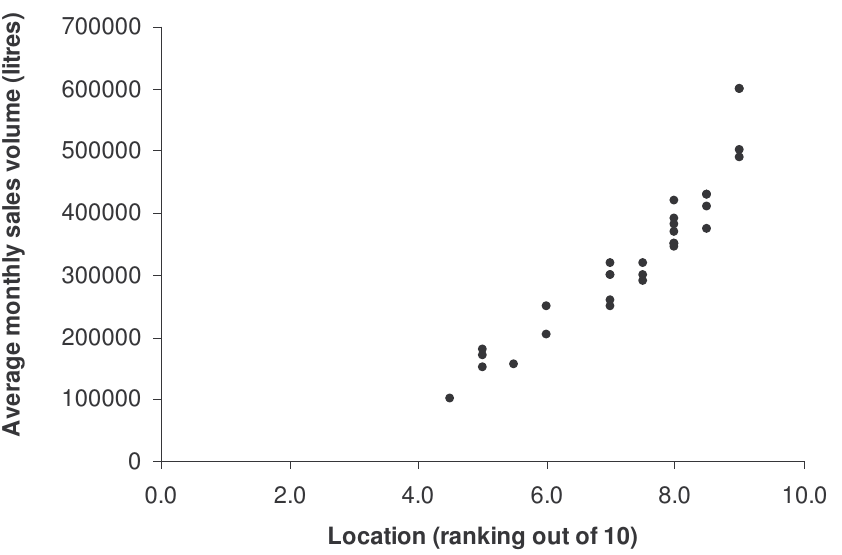
Figure 2: Sales volume versus location